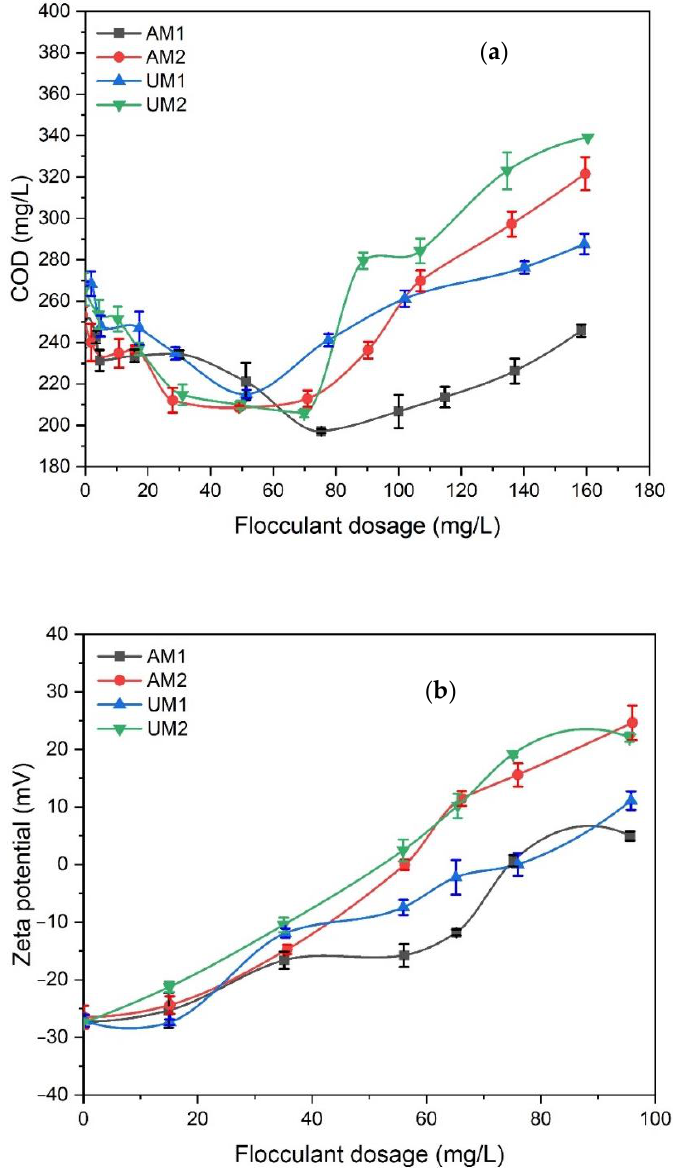
Figure 3. ( a ) COD and ( b ) zeta potential as a function of lignin-METAC dosage for municipal wastewater treatment.